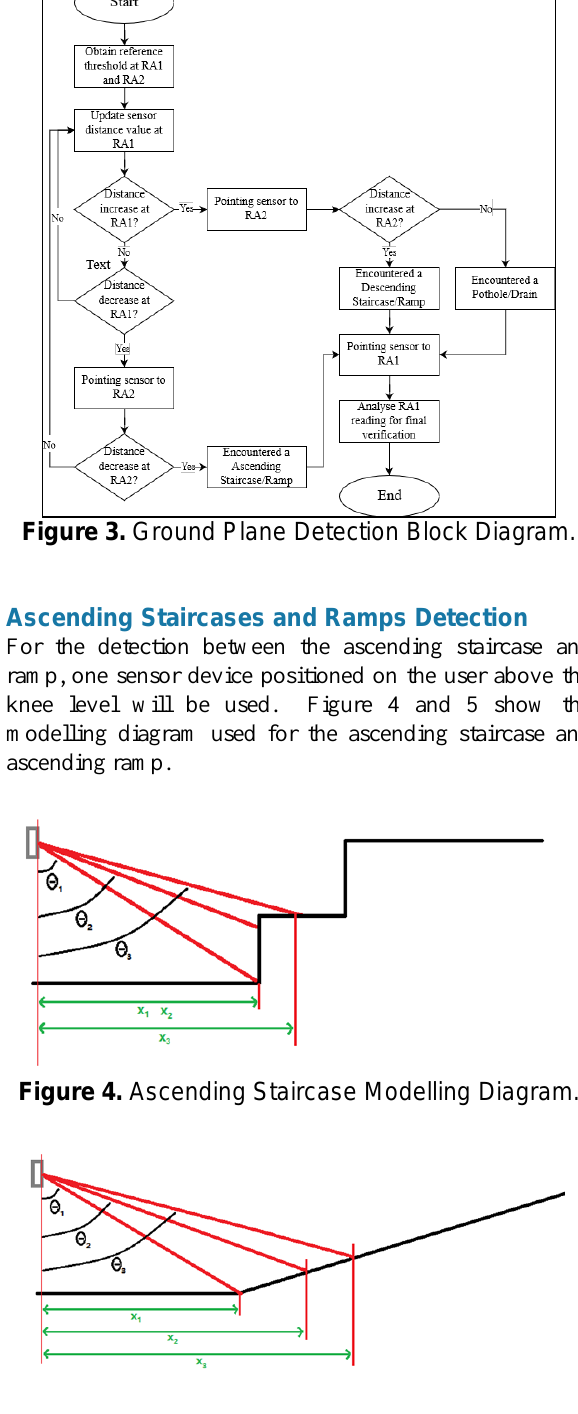
Figure 5. Ascending Ramp Modelling